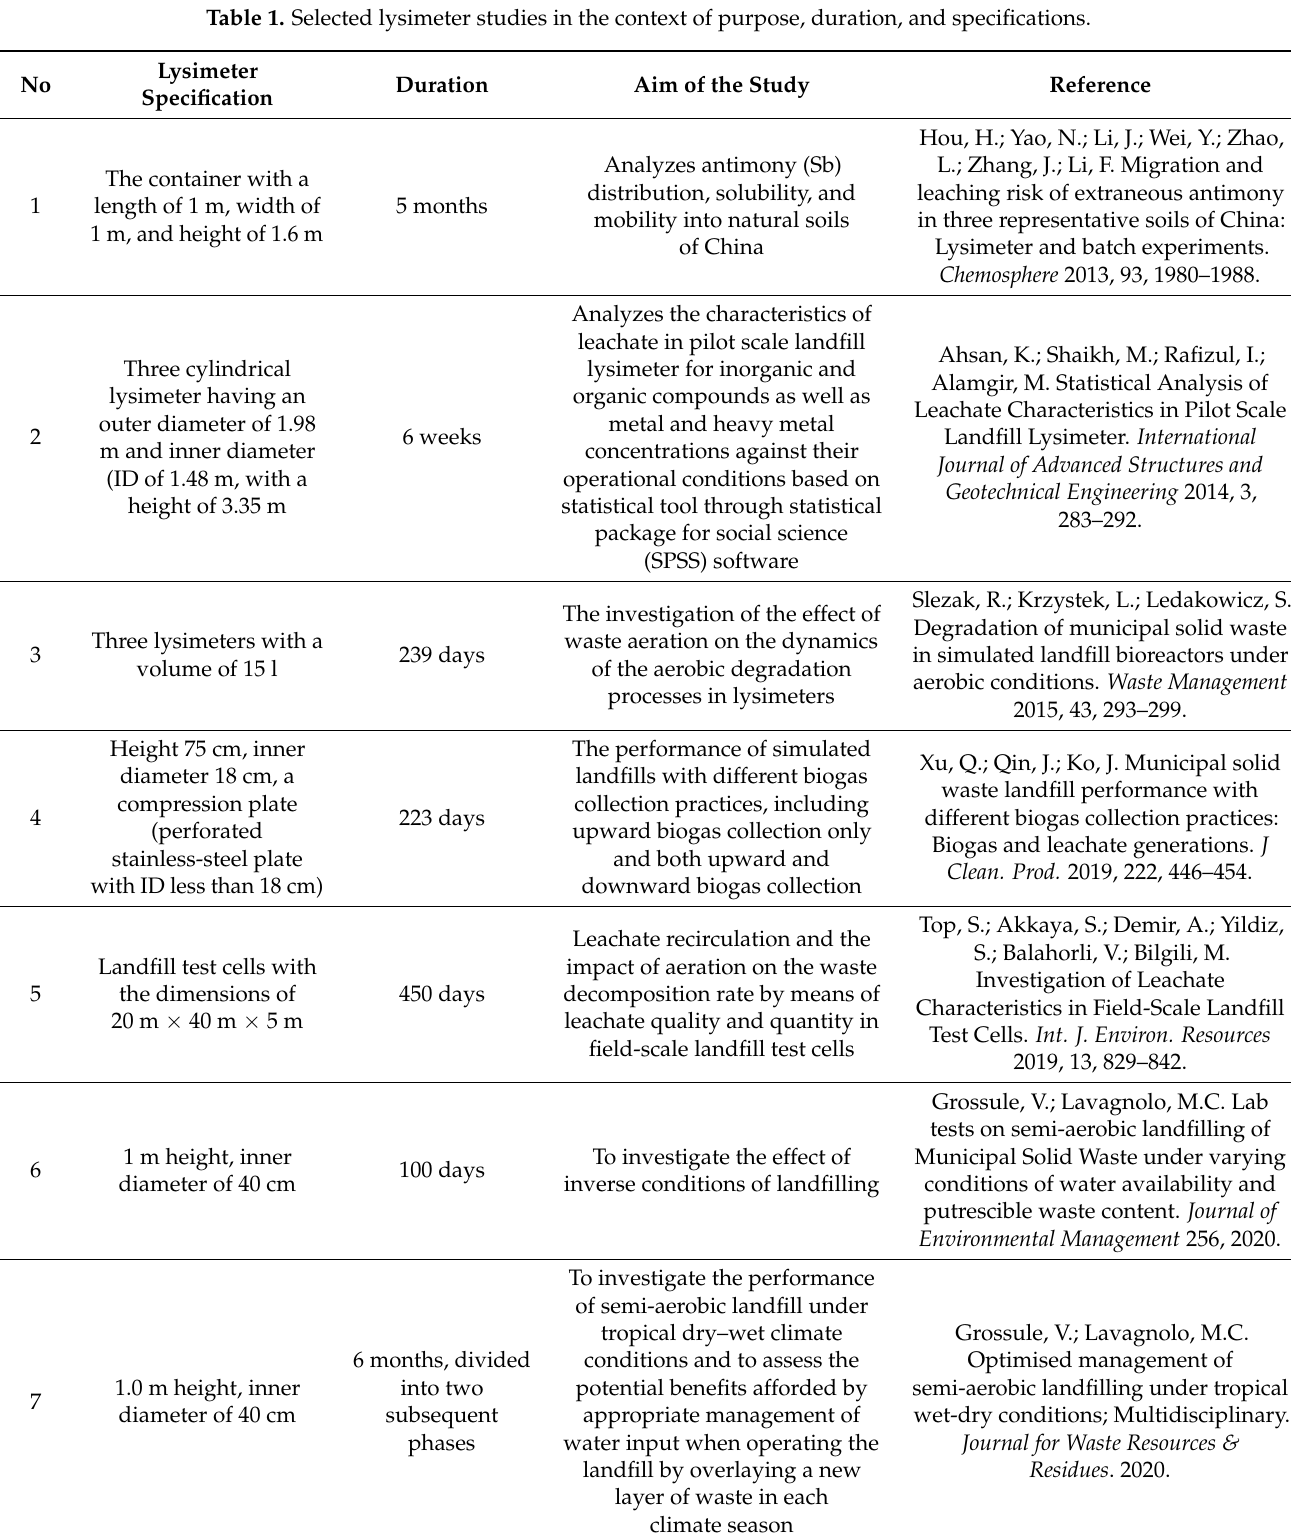
Table 1. Selected lysimeter studies in the context of purpose, duration, and